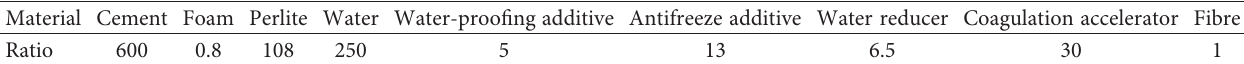
Table 8: Tabulation shows mix proportion of FC used for aseismic isolation layer (unit: kg/m 3 )